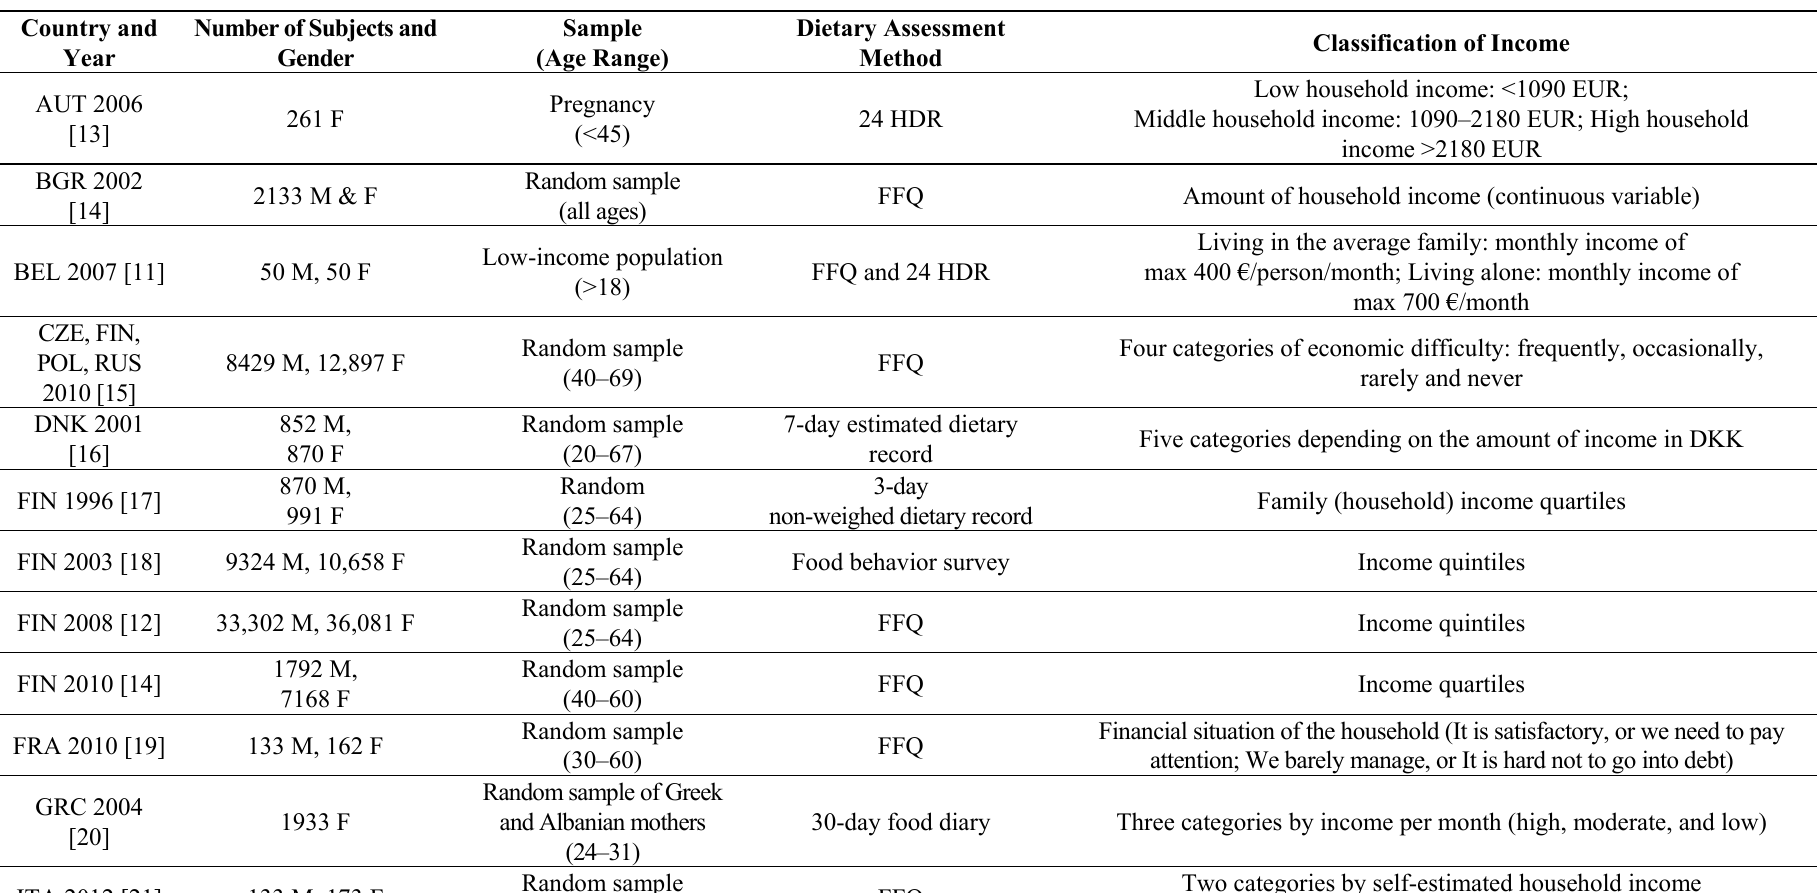
Table 1. Characteristics of included